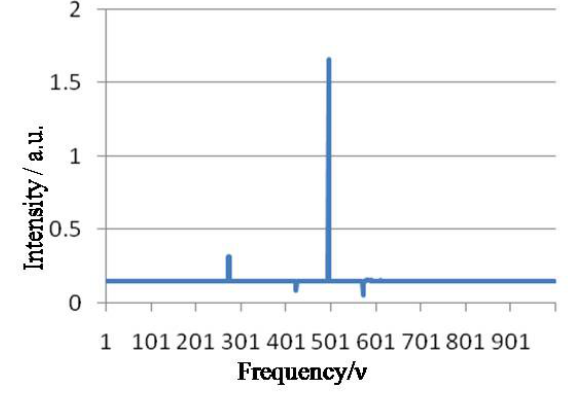
Figure 1. WT transformation of IR-ATR signals of a glucose